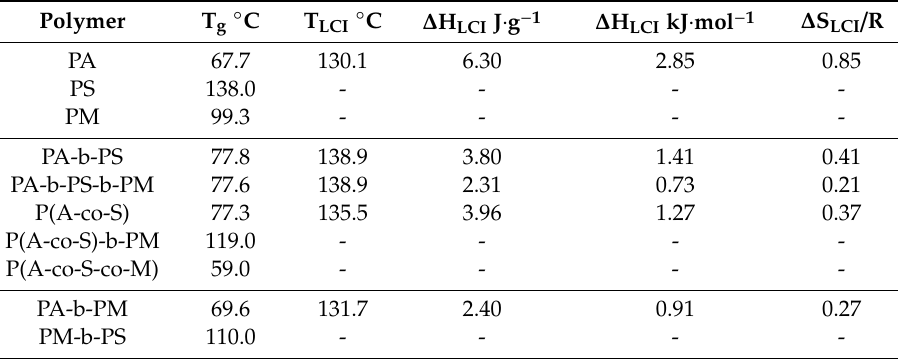
Table 2. Thermal parameters obtained from the DSC thermograms: glass transition, T g ; liquid crystal to isotropic transition temperature, T LCI ; enthalpy, ∆ H LCI ; and reduced entropy, ∆ S LCI /R . All values obtained on second heating scans.